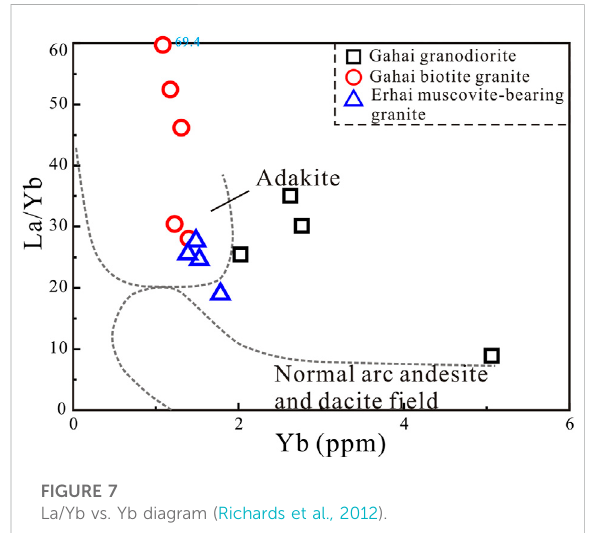
FIGURE 7 La/Yb vs. Yb diagram (Richards et al.,